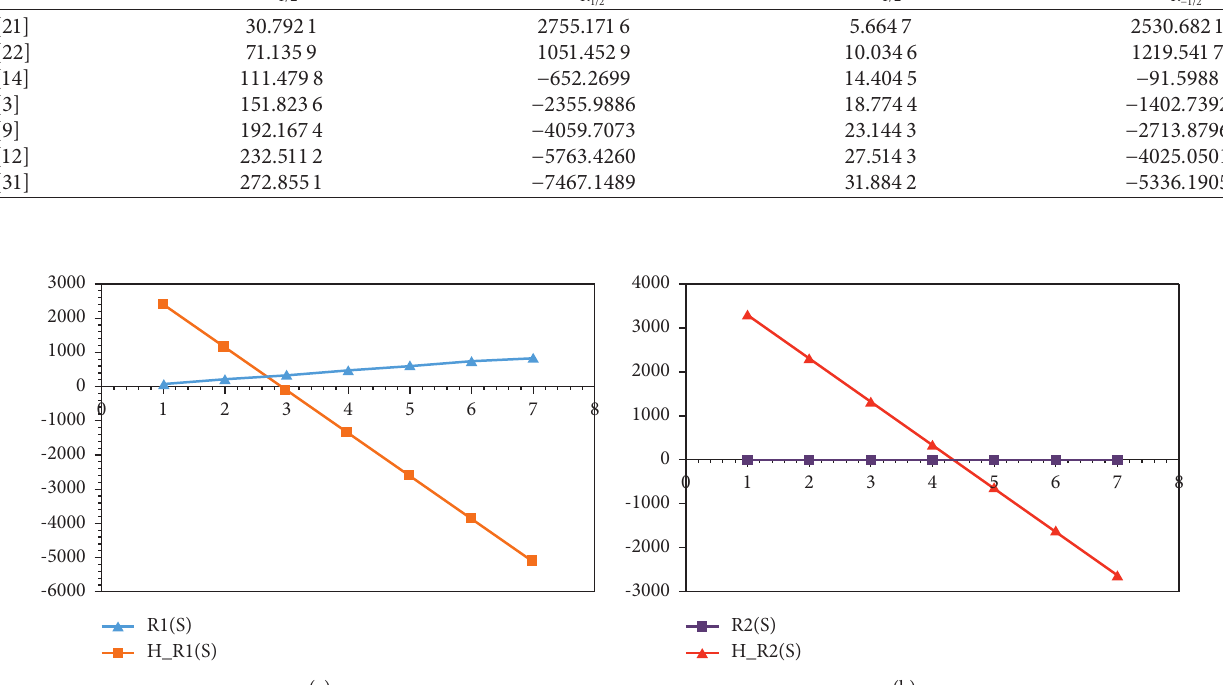
Table 4: Comparison of R